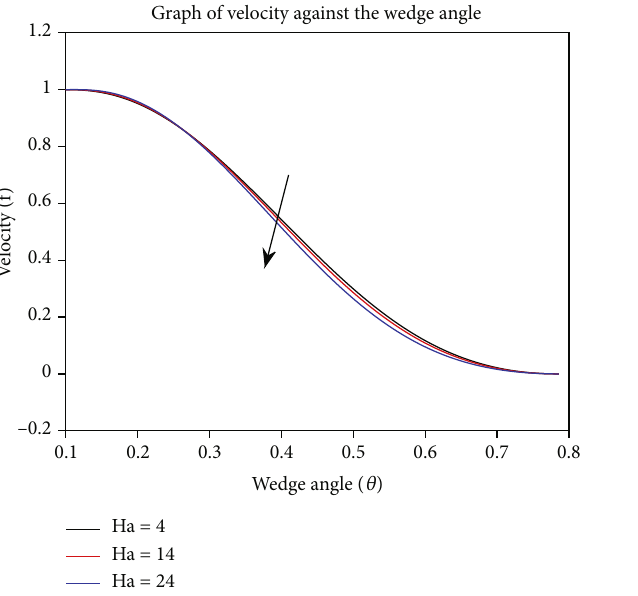
Figure 8: E ff ect of varying the Hartmann number on velocity.